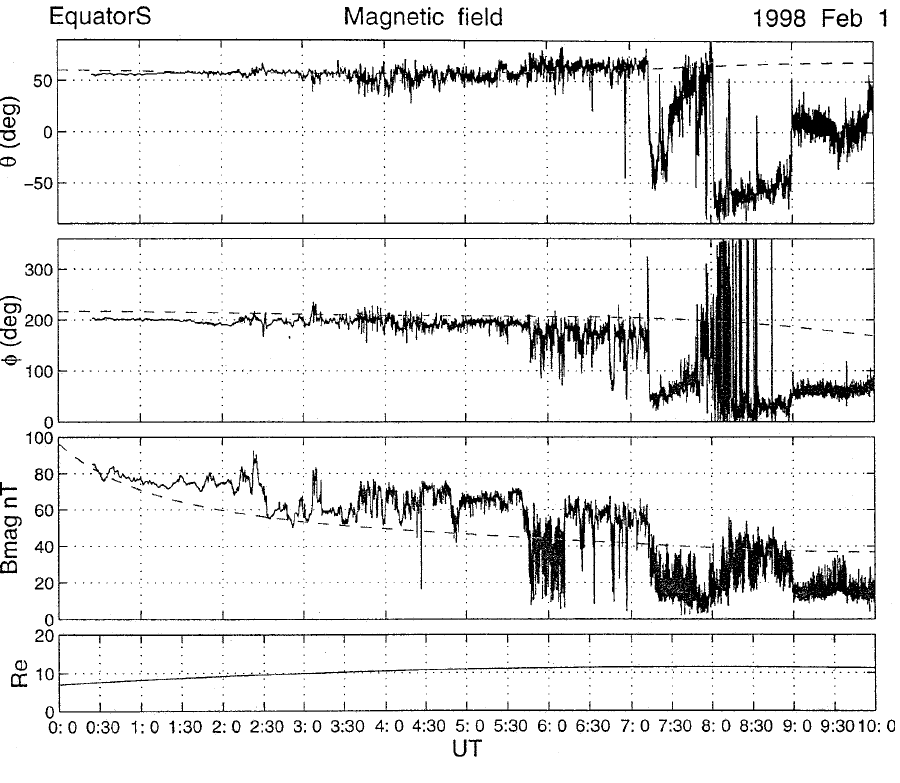
Fig. 12. As for Fig. 5a, for the